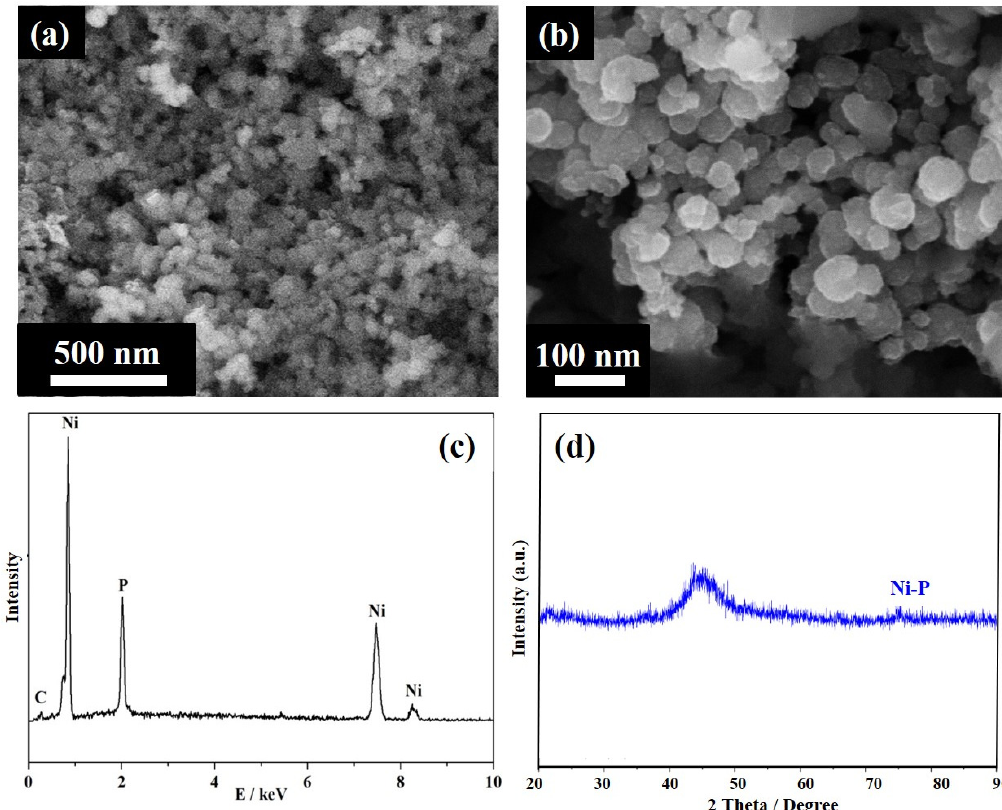
Figure 2. Microstructural characterization of the starting Ni-P catalyst: ( a , b ) SEM images with various magnifications, ( c ) EDS spectrum and ( d ) XRD pattern.